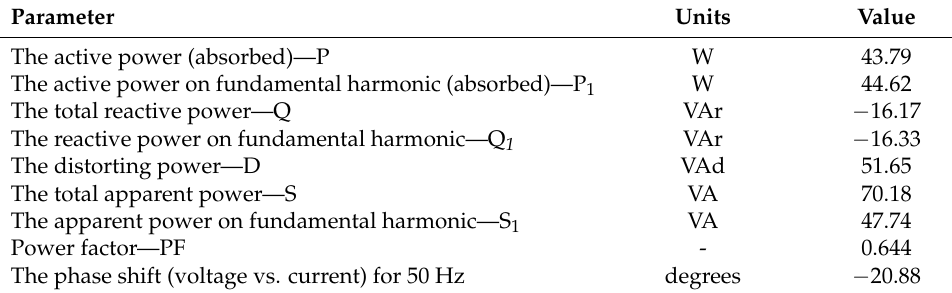
Table 3. Powers and power factor for case